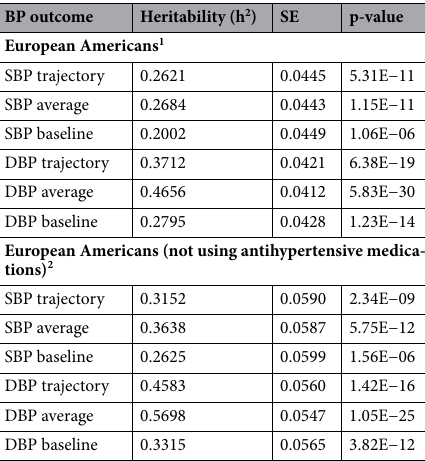
Table 3. Heritability analyses in European Americans using longitudinal and cross-sectional BP outcomes. 1 The "European Americans" heritability analysis was performed using 389,360 SNPs and 8,515 European Americans from the ARIC and MESA studies. 2 The "European Americans (not using antihypertensive medications)" heritability analysis was performed using 389,360 SNPs and 6,372 European Americans from the ARIC